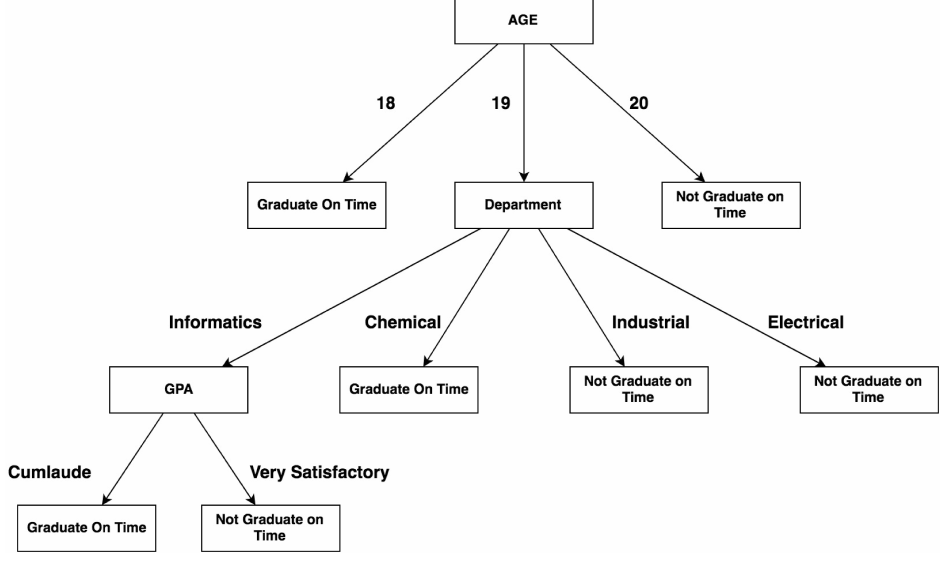
Fig. 2 Decision Tree of Student On-time